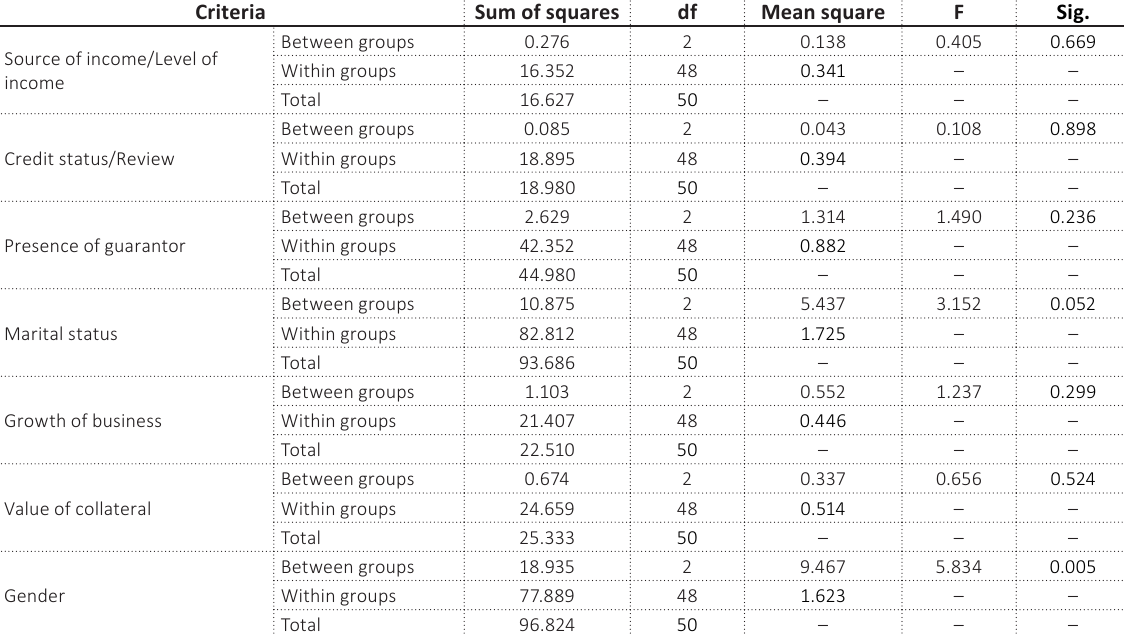
Table 2. ANOVA test on the criteria for access to building credits across different banks